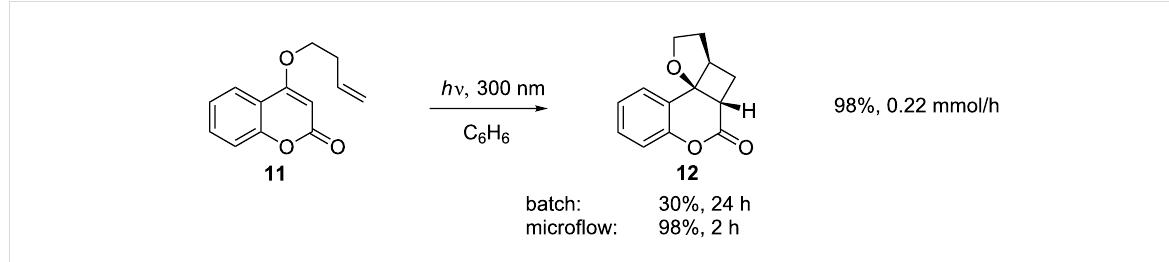
Scheme 4: Comparison of yields and reaction times for a batch reactor with a microflow system.